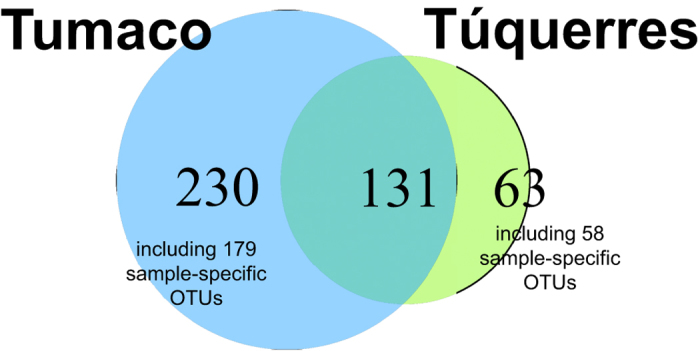
Venn diagram visualizing the number of town-specific and shared OTUs.Numbers of sample-specific OTUs indicated.